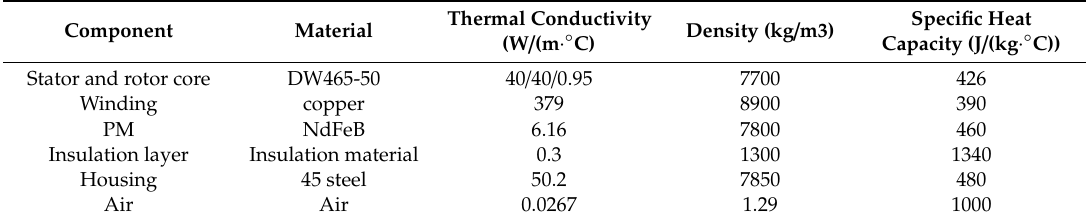
Table 5. Material properties of